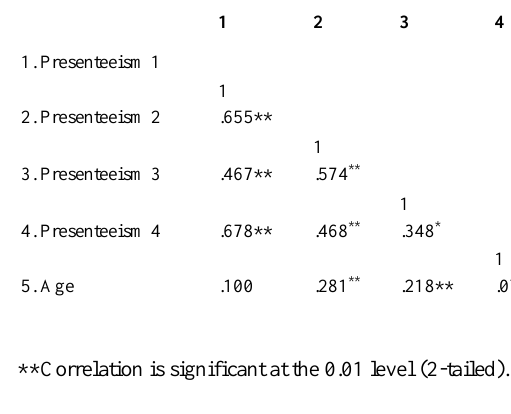
Table 16: Correlations among Reasons and Outcomes of